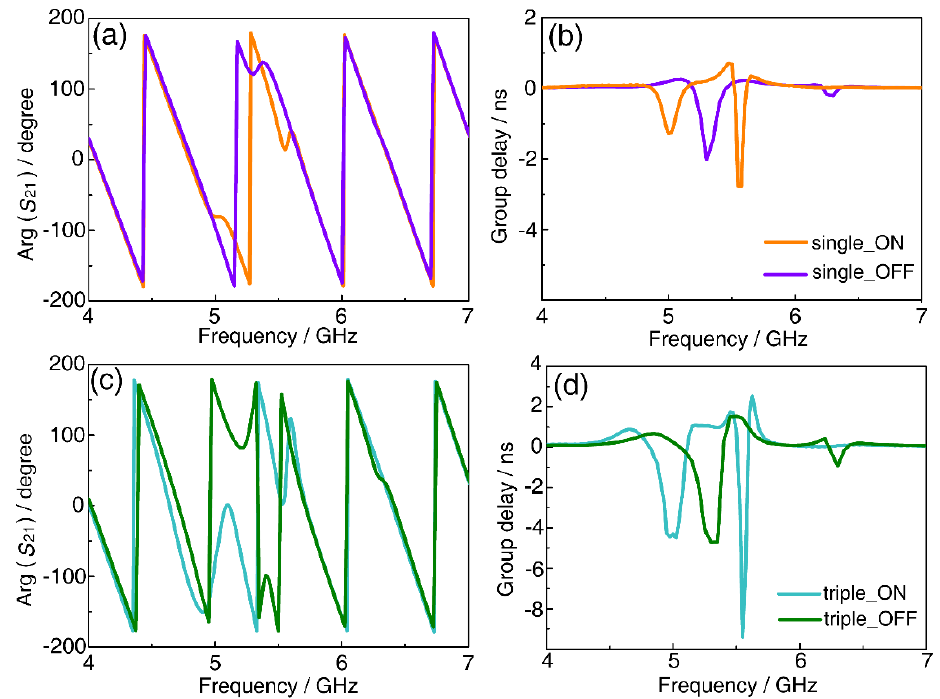
Figure 6. Transmission phases ( a , c ) and calculated group delays ( b , d ) of SSPP waveguide samples loaded with single and triple sets of EIT modules, when the PIN diodes are in the ‘ON’ and ‘OFF’ states.